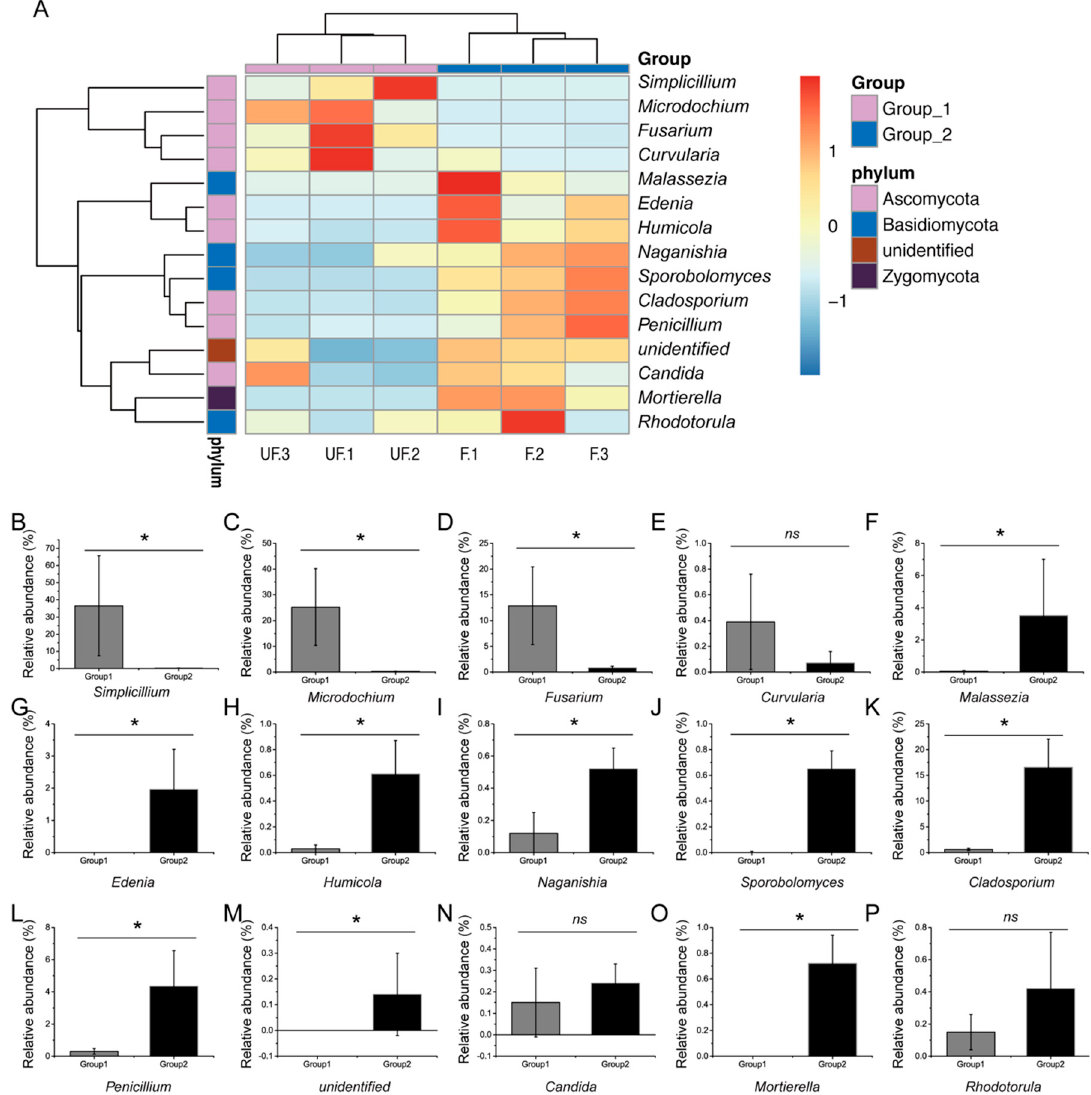
Figure 5. Comparative analysis of microbial abundance in dominant genera. ( A ) Heat map analysis of the dominant phyla in the non-fertilized and fertilized eggs of N. lugens . ( B – P ) Comparative analysis of abundance in the genera of Simplicillium , Microdochium , Fusarium , Curvularia , Malassezia , Edenia , Humicola , Naganishia , Sporobolomyces , Cladosporium , Penicillium , unidentified genus, Candida , Mortierella , and Rhodotorula , respectively. Groups 1 and 2 represent the non-fertilized and fertilized eggs of N. lugens , respectively. Ns: no significant difference between the non-fertilized and fertilized eggs at p < 0.05 levels; * significant difference between the non-fertilized and fertilized eggs at p < 0.05 levels.